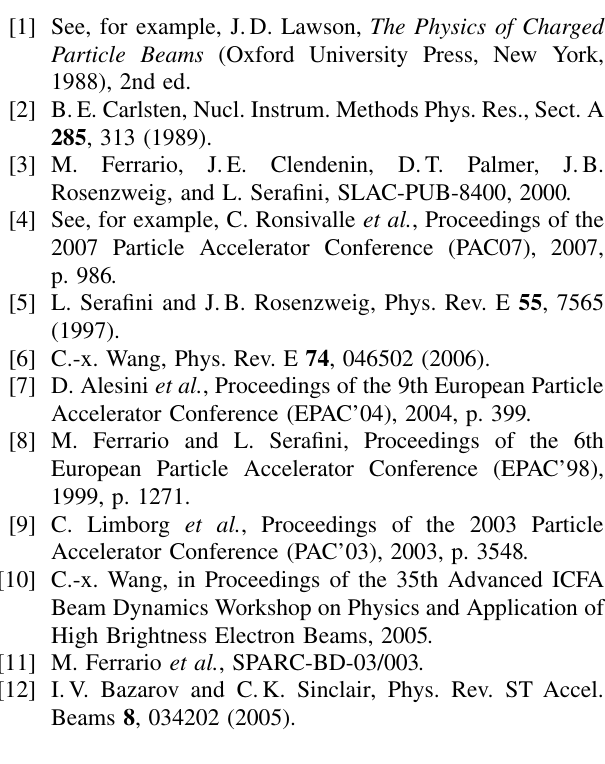
FIG. 8. (Color) W minimum locations agree with those in Fig.